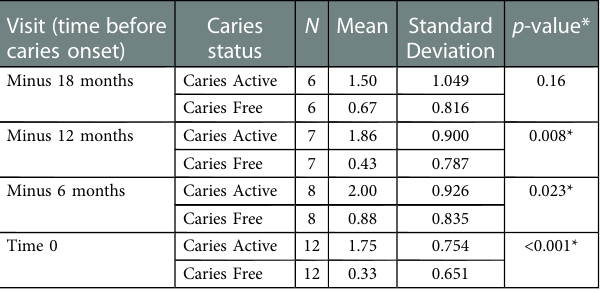
TABLE 1 Microbiological burden and association with caries development across time. Microbial measure Visit (time before caries onset)